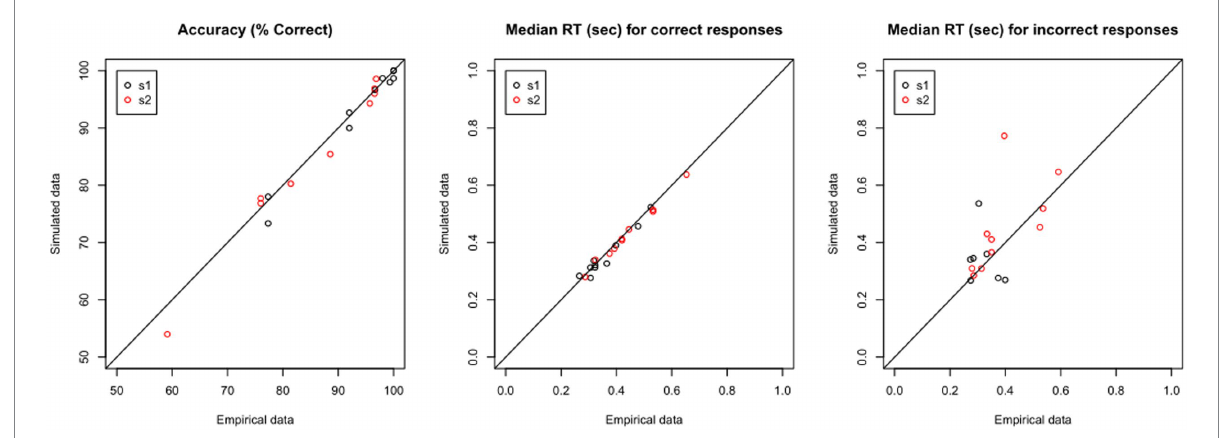
FIGURE 8 Validating the model: Predictive Check. Using the estimated parameters for each data file, shown in Table 4, the DDM is used to generate “simulated data.” For each empirical file, the simulated data should closely reproduce (left) accuracy as well as features of the RT distribution, such as median RT on (center) correct and (right) incorrect responses.